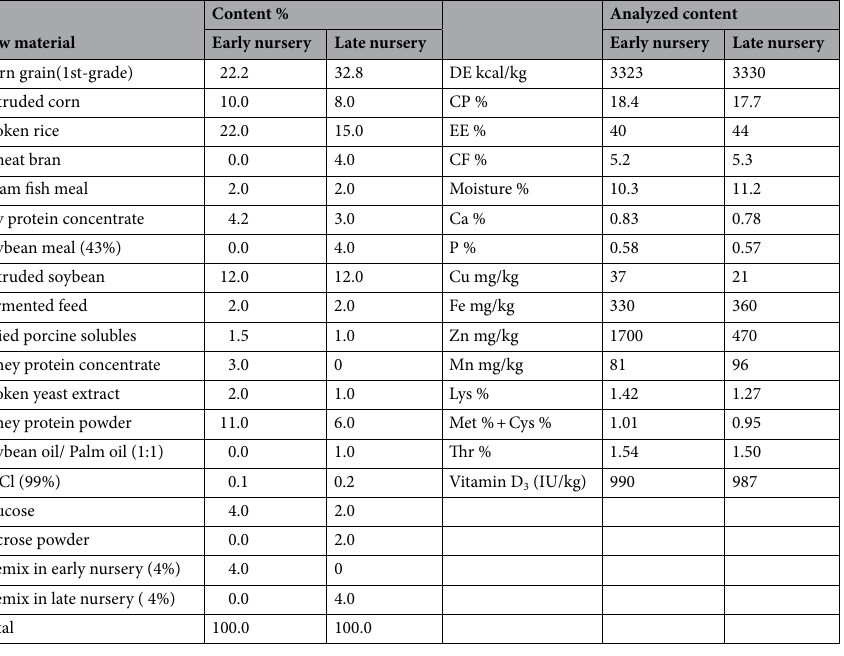
Table 1. Basic diet nutrition formula (left) and analyzed nutrient content (right). Premix in early nursery (4%): The premix provided per kg of diet 100,000 IU of vitamin A, 108 mg of vitamin B 1 , 260 mg of vitamin B 2 , 100 mg of vitamin B 6 , 0.8 mg of vitamin B 12 , 25,000 IU of vitamin D 3 , 1600 IU of vitamin E, 100 mg of vitamin K 3 , 100 mg of niacin, 55 mg of folic acid, 50 mg of pantothenic acid, 10 mg of biotin, 2250 mg of Fe, 1750 mg of Cu, 19,500 mg of Zn, 250 mg of Mn, 15 mg of I, 5 mg of Se. 10% Lys, 5% Met, 13.2% of Ca, 4.7% of P, 2.5% of NaCl. Premix in late nursery (4%): The premix provided per kg of diet 75,000 IU of vitamin A, 80 mg of vitamin B